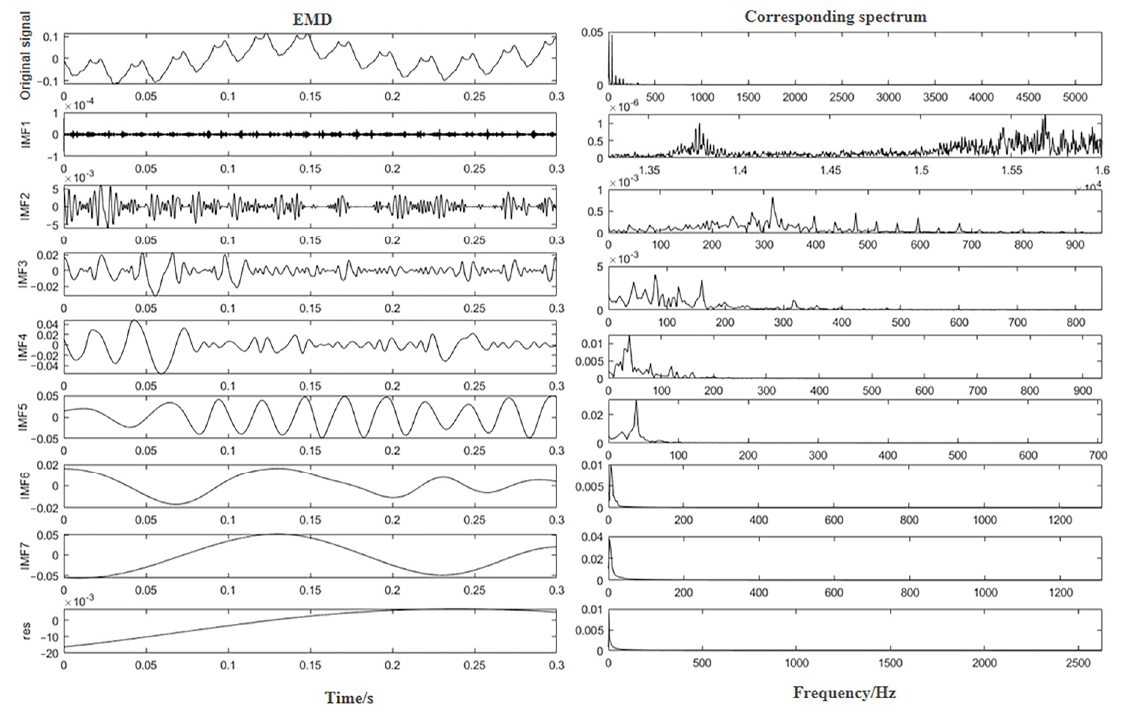
Figure 4. EMD decomposition results of rotor misalignment fault signals.